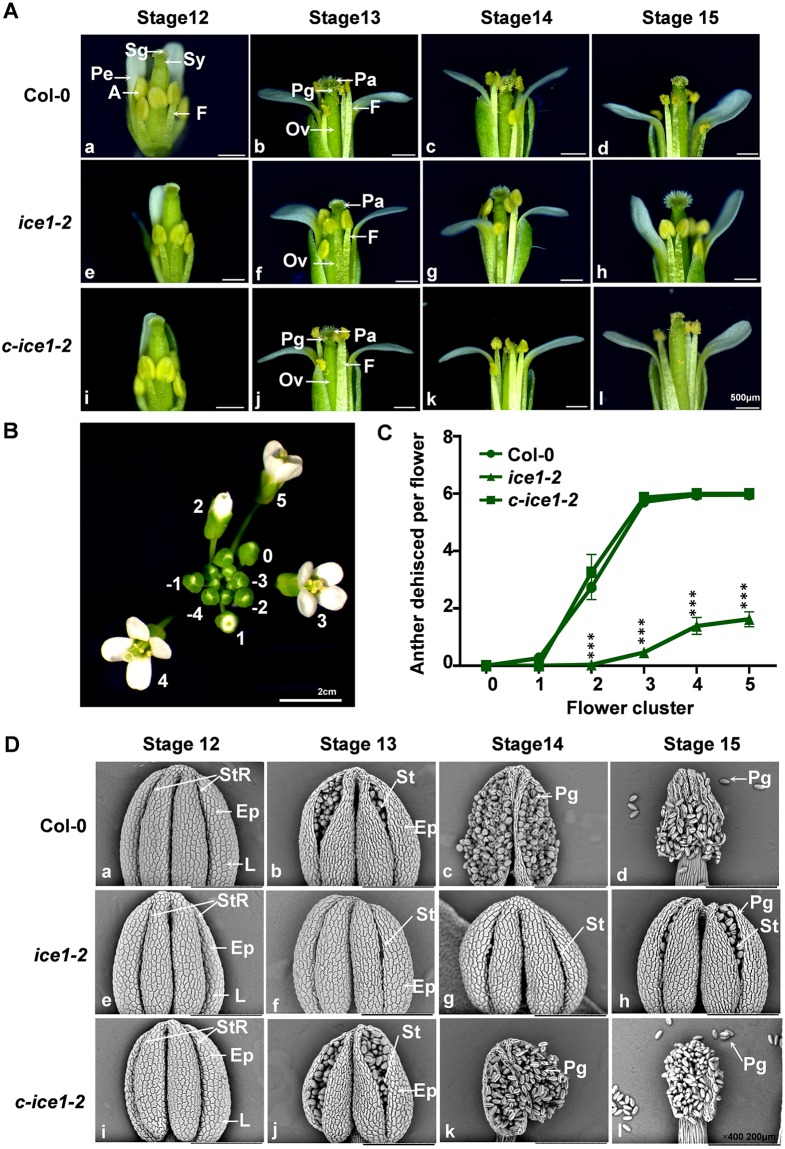
Stamen morphology and anther dehiscence in ice1-2.(A) Developmental series of flowers at flower developmental stage 12–15 within a single inflorescence from Col-0, c-ice1-2 and ice1-2. A, anther; F, filament; Ov, ovary; Pa, stigmatic papilla; Sg, stigma; Sy, style; Pe, Petal; Pg, Pollen grain. (B) Flower cluster showing the developmental series used to quantitatively describe anther dehiscence. The number 0 indicates the beginning of flower stage 12; 2 indicates the end of stage 12; 1 (stage 12); 3 (stage 13); 4 (stage 14); 5 (stage 15); -1 (stage 11); -2 (stage 11); -3 (stage 10); -4 (stage 9). (C) The number of dehiscent anthers in plants (SE, n = 15–28 flowers, one inflorescence per plant was used, *** p < 0.001). (D) Scanning electron micrographs of the anther adaxial surface from flower stage 12–15. St, stomium; En, epidermis; L, locule, StR, stomium region; Pg, Pollen grain.